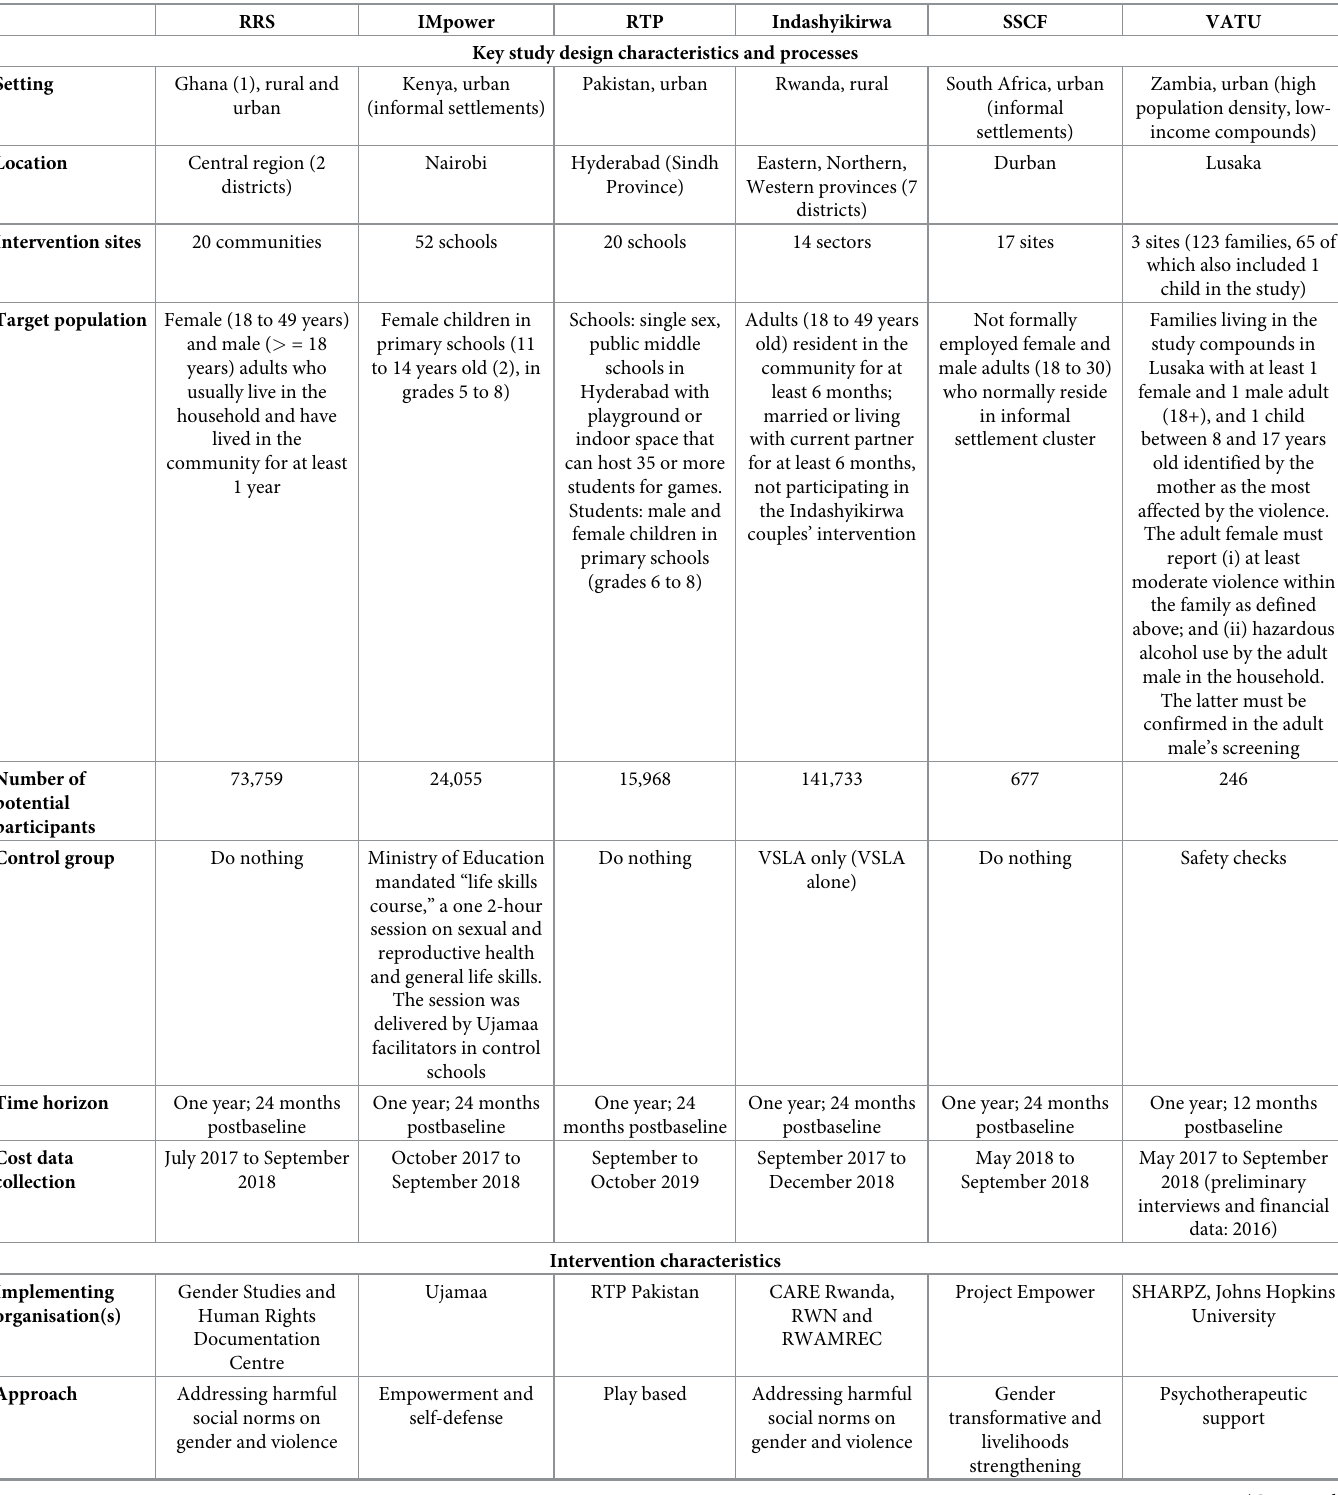
Table 1. Intervention descriptions—Research setting.